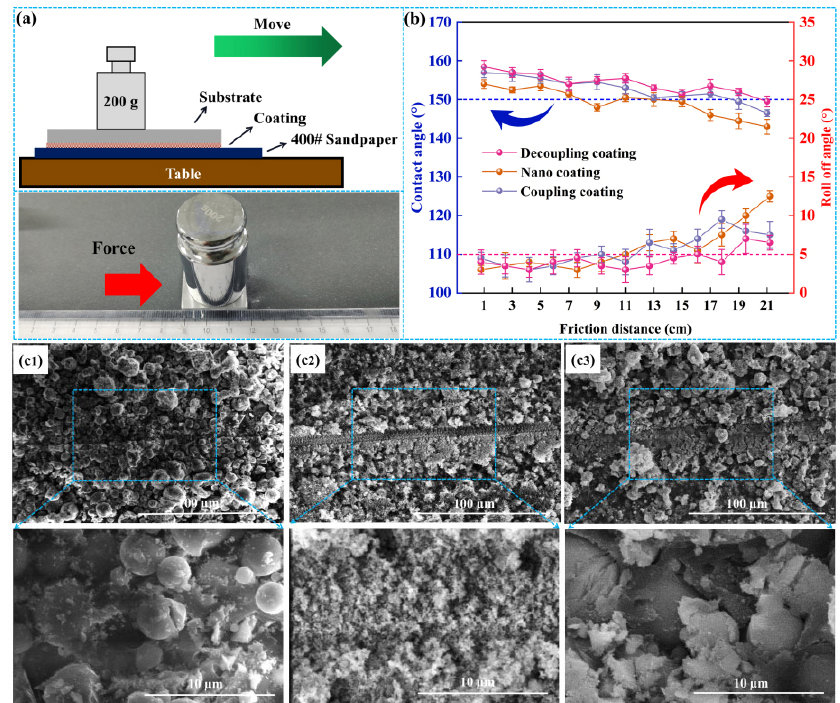
Fig. 5 (a) Schematic diagram of sandpaper abrasion test; (b) CAs and RAs of water droplets after abrasion for different distances; and SEM images of (c1) decoupling, (c2) nano, and (c3) coupling coatings after abrasion for 9 cm.